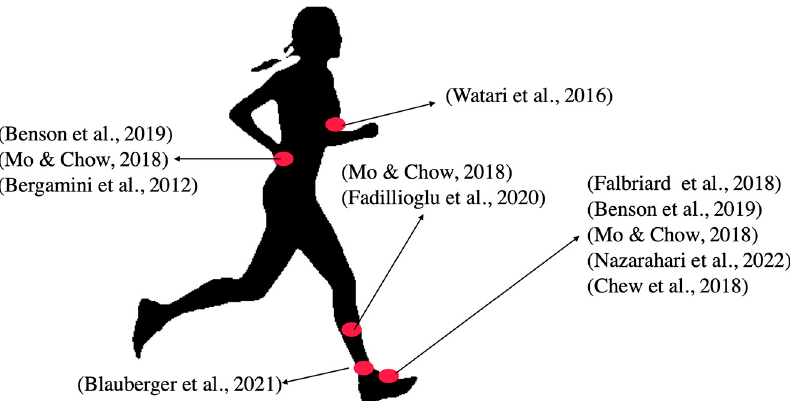
Figure 1. IMU location of the reference works, selected from the state of the art, as a result of a systematic search. References: (Falbriard et al., 2018), [7]; (Benson et al., 2019), [8]; (Mo & Chow, 2018), [9]; (Nazarahari et al., 2022), [10]; (Chew et al., 2018), [11]; (Blauberger et al., 2021), [12]; (Fadillioglu et al., 2020), [13]; (Bergamini et al., 2012), [14]; (Watari et al., 2016), [15].